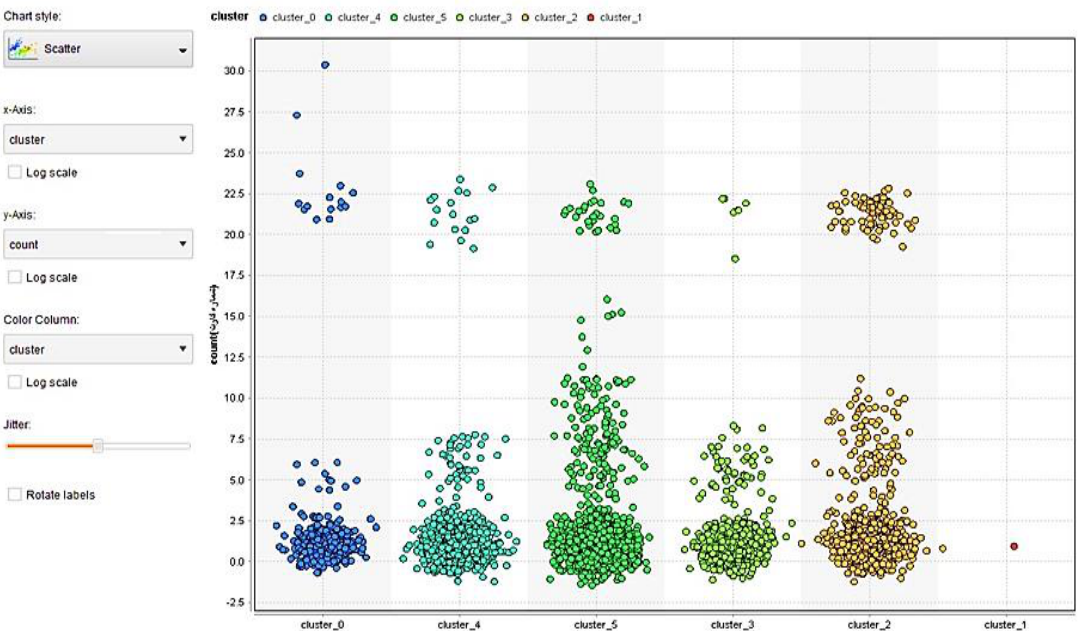
Fig. 4. Data distribution diagram in six